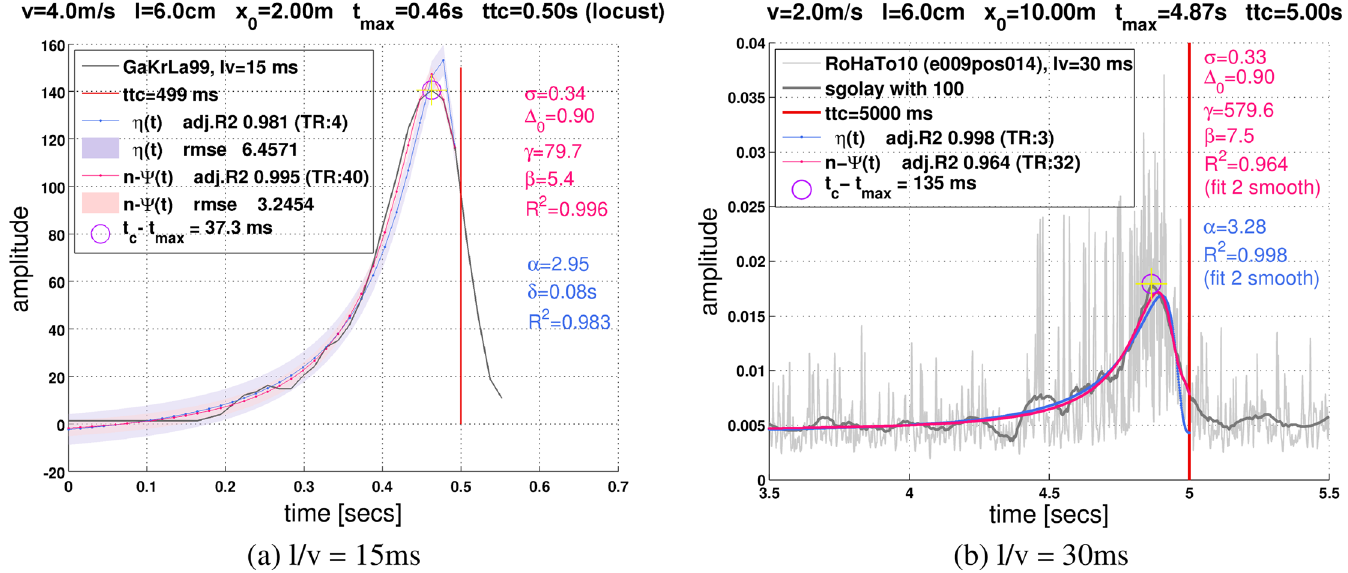
Fig 6. Prediction of LGMD responses by n- ψ . ( a )The figure shows the data from figure 3 of reference [17] (locust), where looming dark squares were used for stimulation ( t c = 0.5s: vertical red line). The η -function and n- ψ perfectly match these data. More examples are shown in Section D.5 in S1 Text. ( b )DCMD spike trace in response to an approaching black square ( t c = 5s, l / j v j = 30ms, ref. [29]) directed to the eye center of a gregarious locust (final visual angle 50 o ). Data show the first stimulation so habituation is minimal. The spike trace (sampled at 10 4 Hz) was full wave rectified, lowpass filtered, and sub-sampled to 1ms resolution. Firing rate was estimated with Savitzky-Golay filtering ( “ sgolay ” ), and fit by the η -function and n- ψ , respectively. Both functions fit the firing rate estimates very nicely. More details and further examples are provided in Section D.6 in S1 Text.